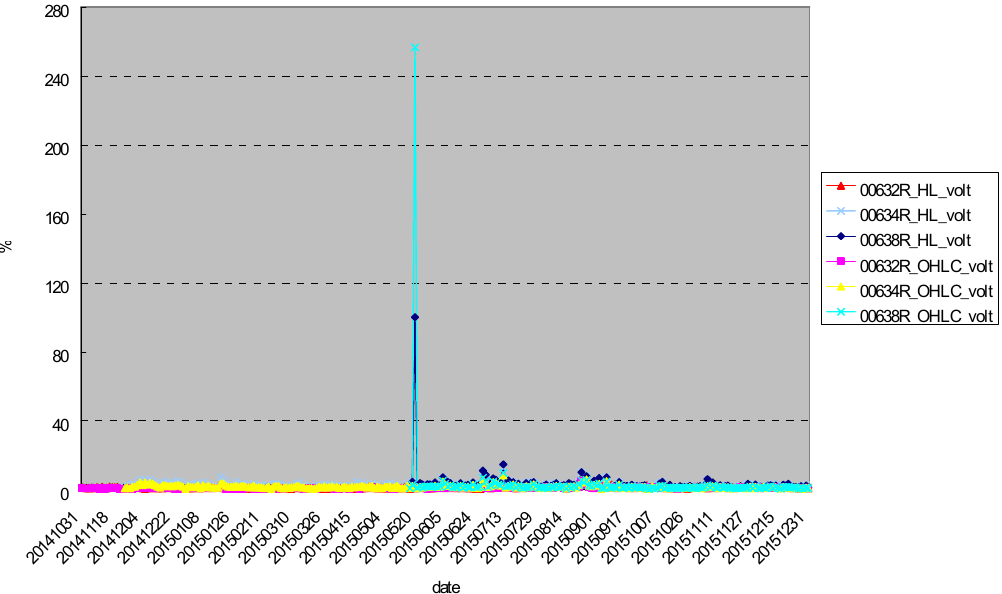
Fig. 2. Daily volatility of the three inverse ETFs, October 31, 2014 to December 31,